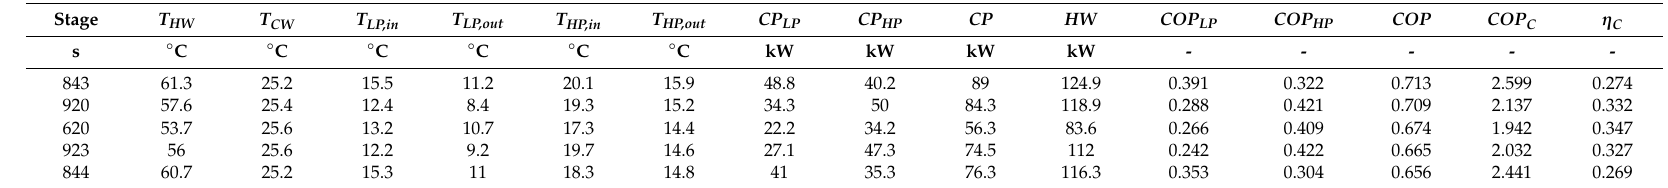
Table 6. Results of 5 measurements with the highest COP value (new control system).